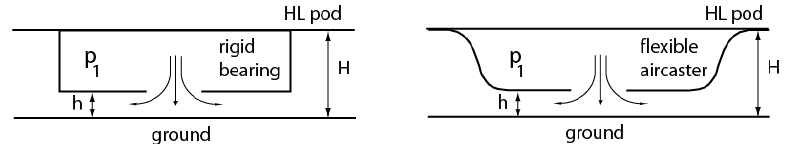
Figure 2. Air bearings can be rigid units, as shown on the left, or flexible ‘air-casters’ as shown on the right.